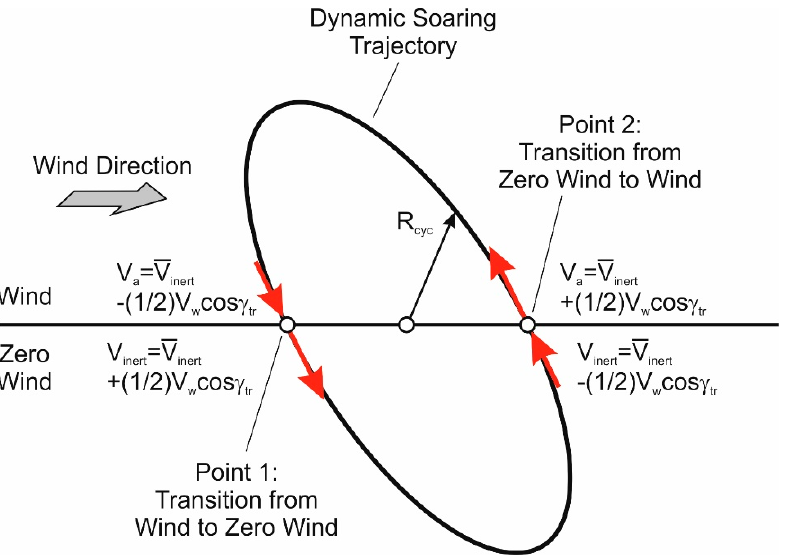
Figure 3. Oblique view on high-speed dynamic soaring loop . (The inclination of the trajectory relative to the horizontal is shown exaggerated for representation purposes) .